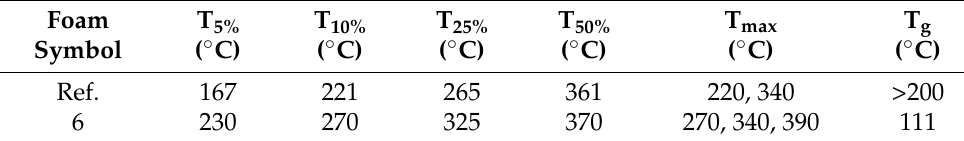
Table 5. Results of thermogravimetric analysis.